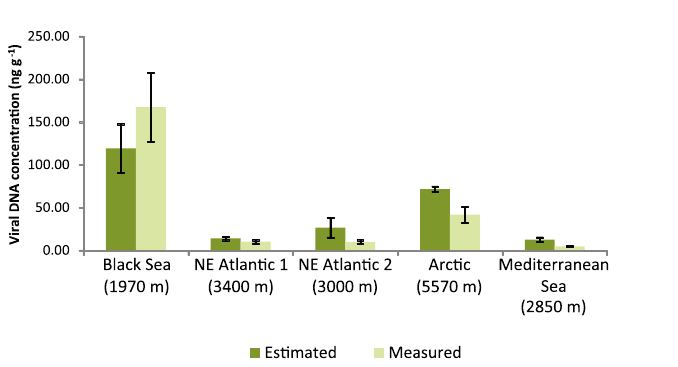
Figure 2. Comparison between viral DNA concentrations measured fluorometrically and DNA concentrations estimated by converting viral abundances into DNA equivalents. Mean (n = 3) and standard deviations are